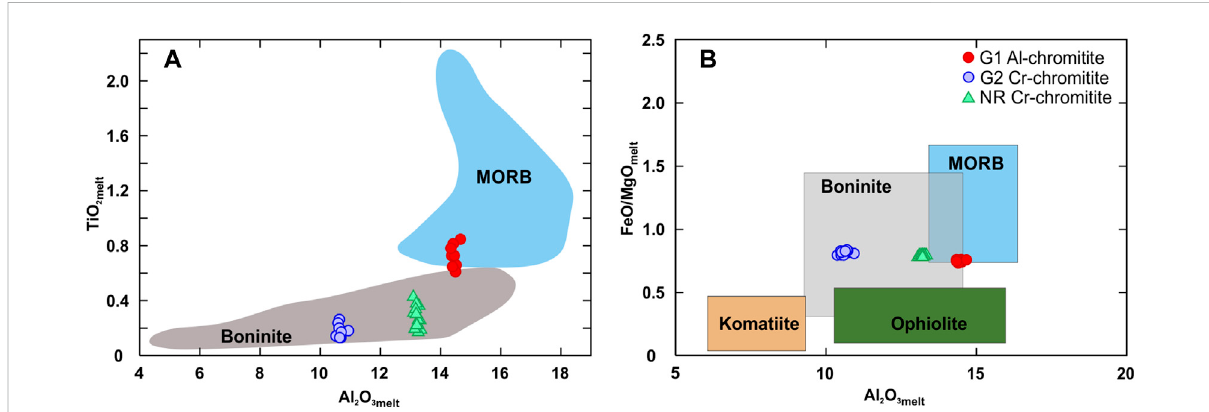
FIGURE 12 Calculatedchromititeparentalmeltcompositions (A) Al 2 O 3 vs. TiO 2 ( fi eldsofMORB:leRoexetal.(1987)and fi eldsofBoninite:Kamenetskyetal. (2001) and references therein and (B) FeO/MgO vs. Al 2 O 3 , fi elds are after Barnes and Roeder